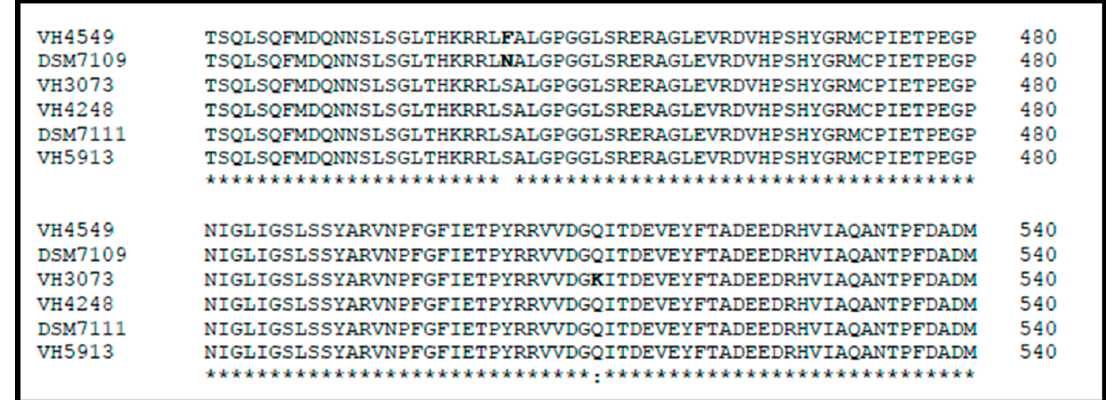
Figure 1. Alignment of RNA polymerase β subunit (RpoB) (residues 421–540) of six Corynebacterium urealyticum strains. Strains VH4549, DSM 7109, and VH3073 are resistant to rifampicin whereas VH4248, DSM 7111, and VH5913 are susceptible.